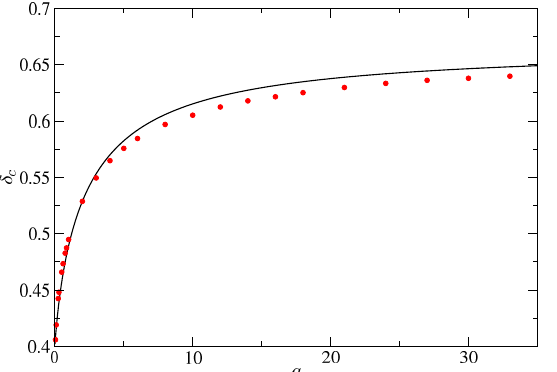
Figure 23. Plot of δ c ( q ) for w = 1/3. The solid black line corresponds to the analytical estimation of Equation (101). Red points correspond to the numerical thresholds of Equation (82) with w =